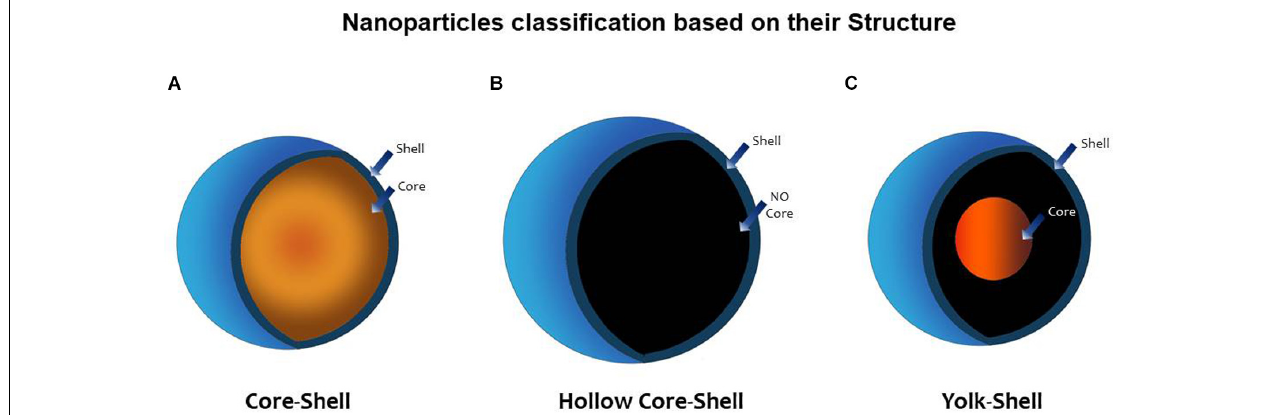
FIGURE 2 | Nanoparticle classification based on its structure. (A) Core–shell (CS) nanoparticle (NP) possesses a central core (NP) surrounded by one or more layers of different material [shell(s)]. (B) Hollow core–shell structure or ( hollow NP) refers to an NP without a core; the resulting empty space inside the shell can then be loaded with drugs, microRNA (miRNA), genes, peptides, and others that can now be released in a controlled manner. (C) Y olk–shell (YS) NP possesses a movable core that is located in a hollow cavity surrounded by a shell (Purbia and Paria,